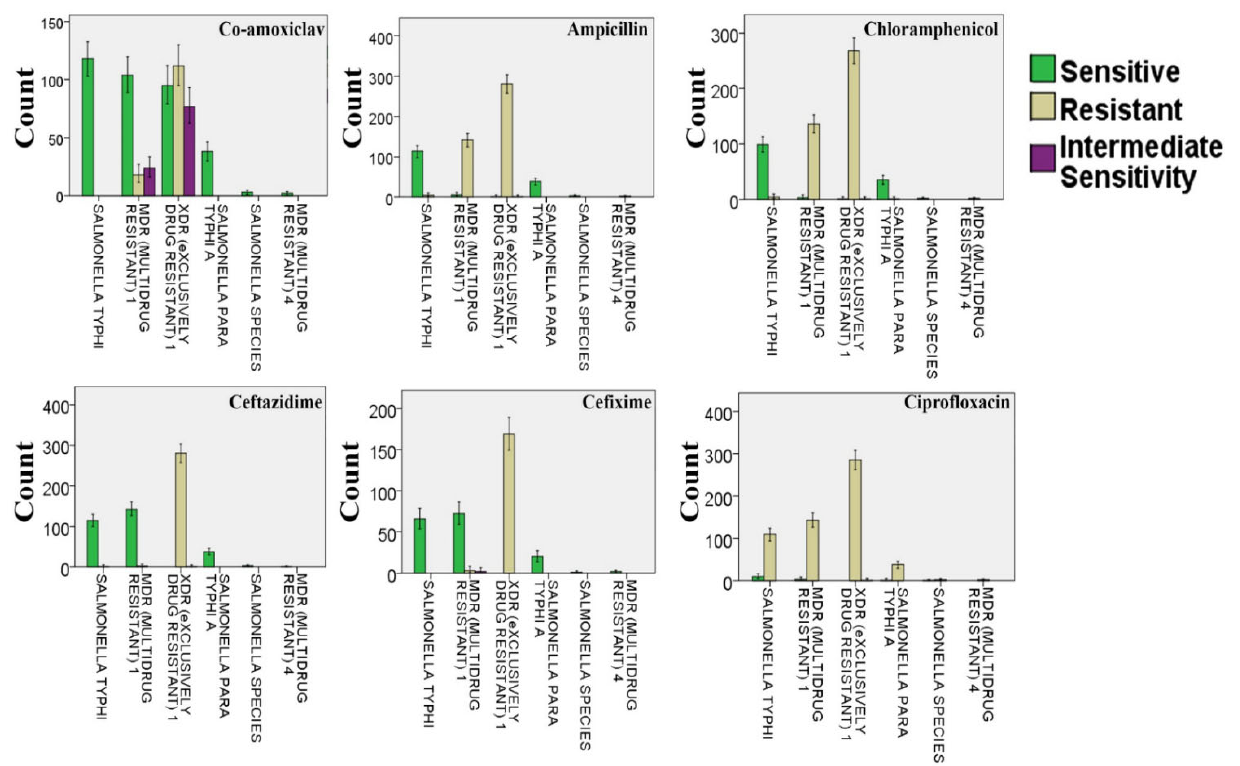
Figure 2. Resistance of different Salmonella strains against co-amoxiclav, ampicillin, chloramphenicol, ceftazidime, cefixime, and ciprofloxacin. The bars present the number of cases with resistant, sensitive, and intermediately sensitive strains against the mentioned antibiotics, whereas the error bars present a 95% confidence